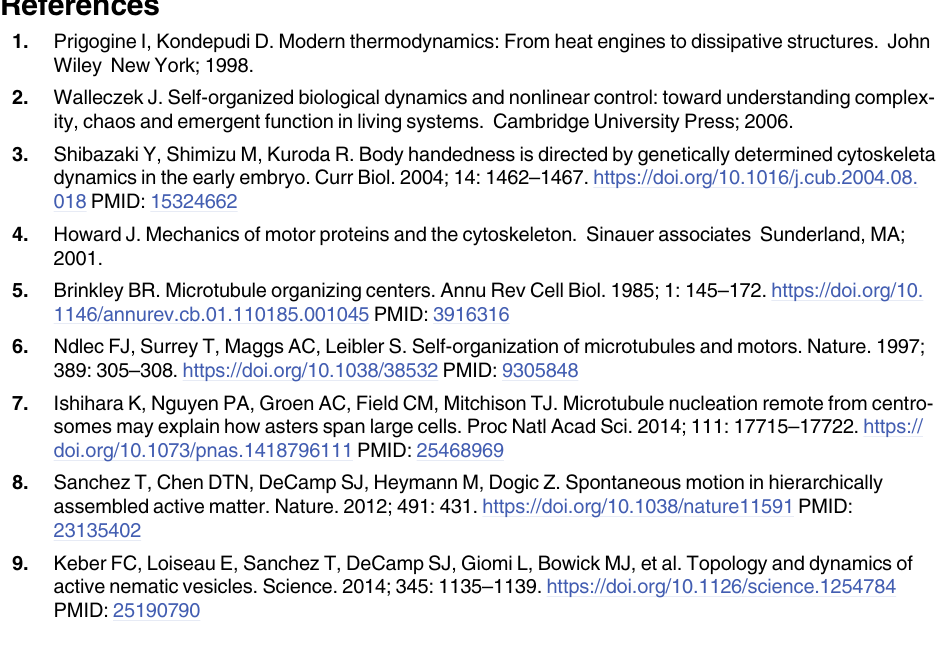
) was used 2 μ L for placing the 2